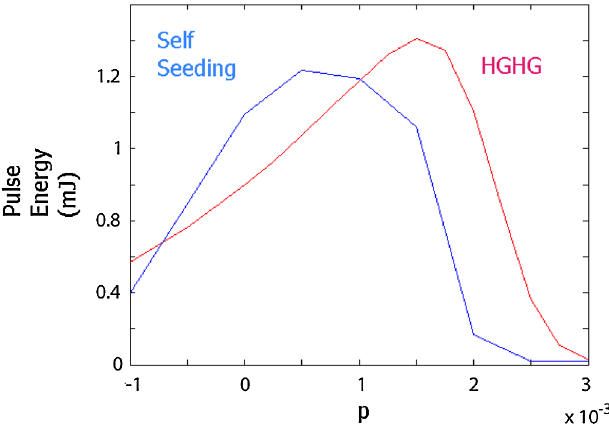
FIG. 8. (Color) Slice normalized energy (black solid line) and current (red dashed line) as a function of position along the beam for the SPARX 1.5 GeV, 1 nC beam, obtained from a start-to-end simulation.